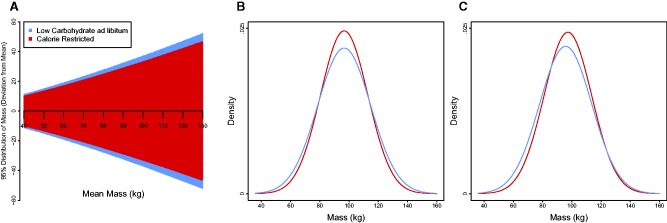
(A) Shaded areas give the predicted 2.5–97.5 percentiles in mass (kg) for a given mean mass (kg), as predicted by the MLMR of lnSD assuming a normal distribution. (B) Predicted probability densities for mass after 6 months on each diet based on the SD estimated by MLMR of lnSD, assuming a mean mass of 96.7 kg (the mean mass of all subjects as estimated by meta-analysis). (C) Predicted probability densities for mass after 6 months on each diet based on the SD estimated by MLMR of lnSD, assuming a different mean mass on each diet. For full MLMR coefficients see Supplementary Material S2